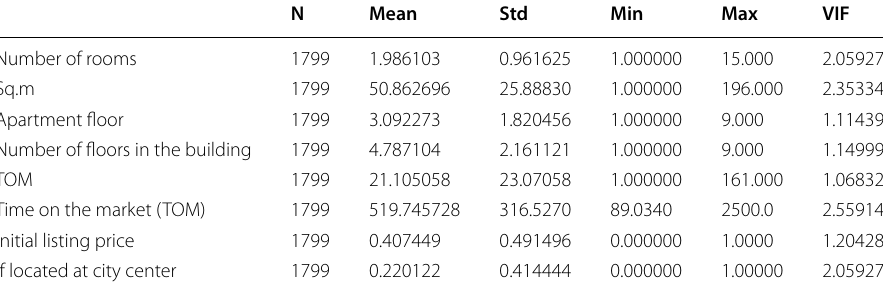
Table 4 Sample descriptive statistics for month May rent operations